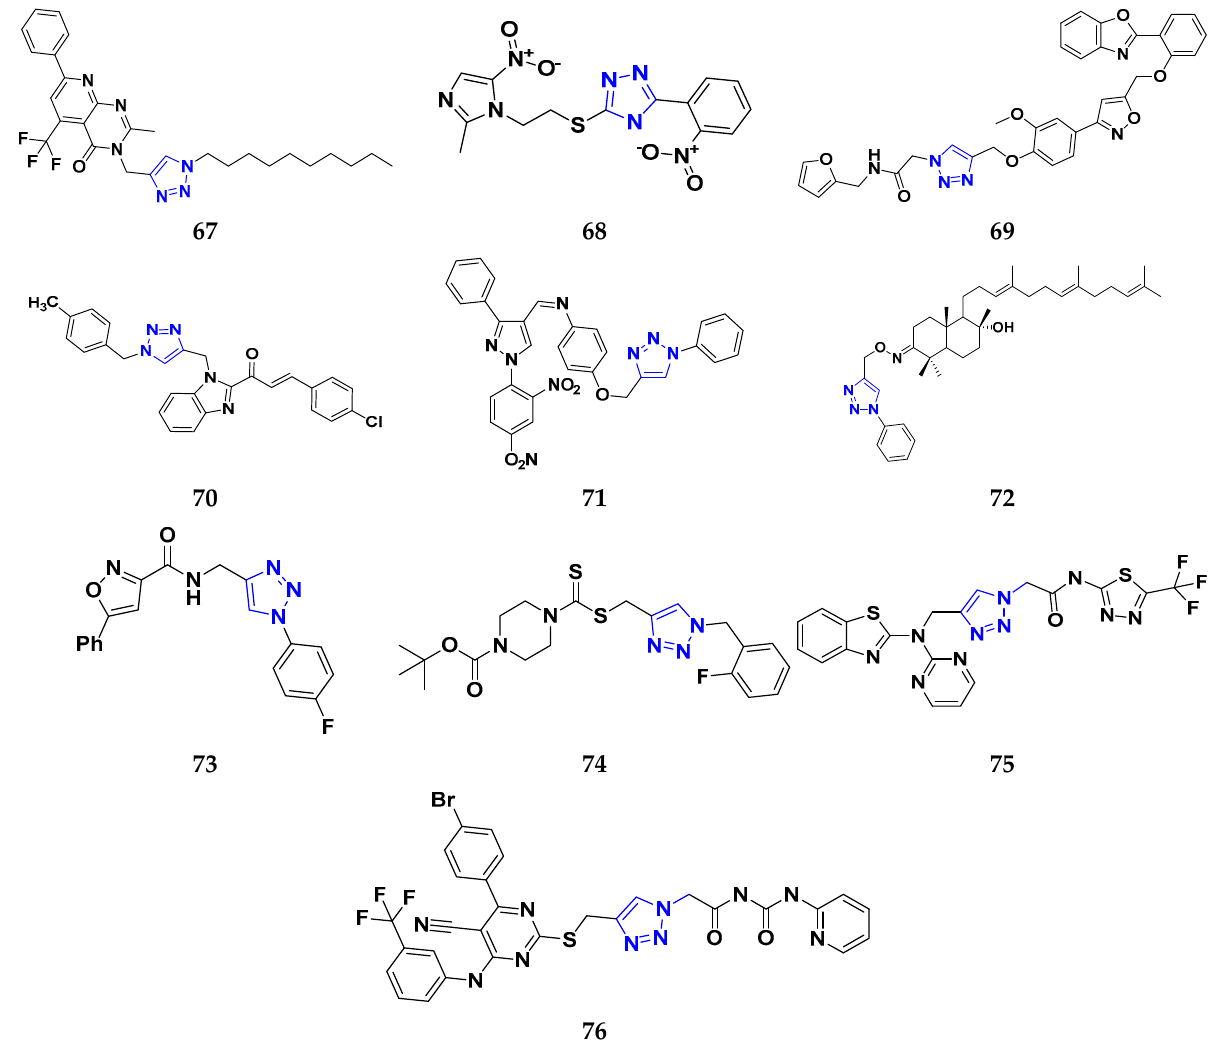
Figure 9. Triazole derivatives ( 67 – 76 ) as anticancer